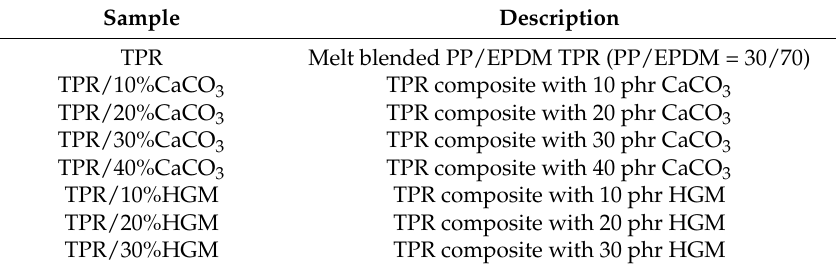
Table 1. The detailed specification of thermoplastic rubber (TPR) based